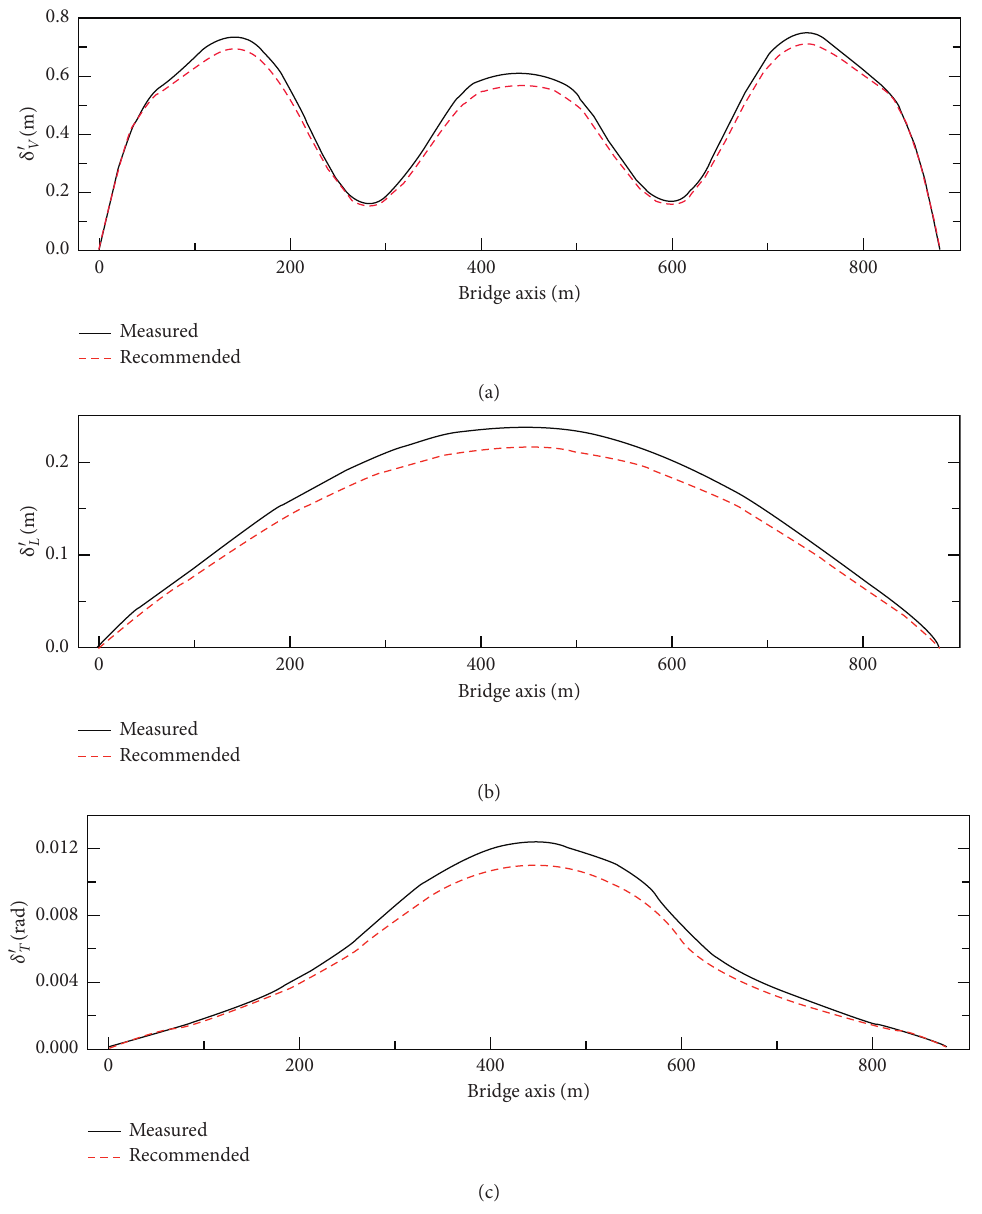
Figure 16: The influences of AAF turbulence power spectra on the buffeting responses at AoA of 0 ° (Case 1): (a) RMS vertical displacement δ V ′ ; (b) RMS lateral displacement δ L ′ ; (c) RMS torsional displacement δ T ′